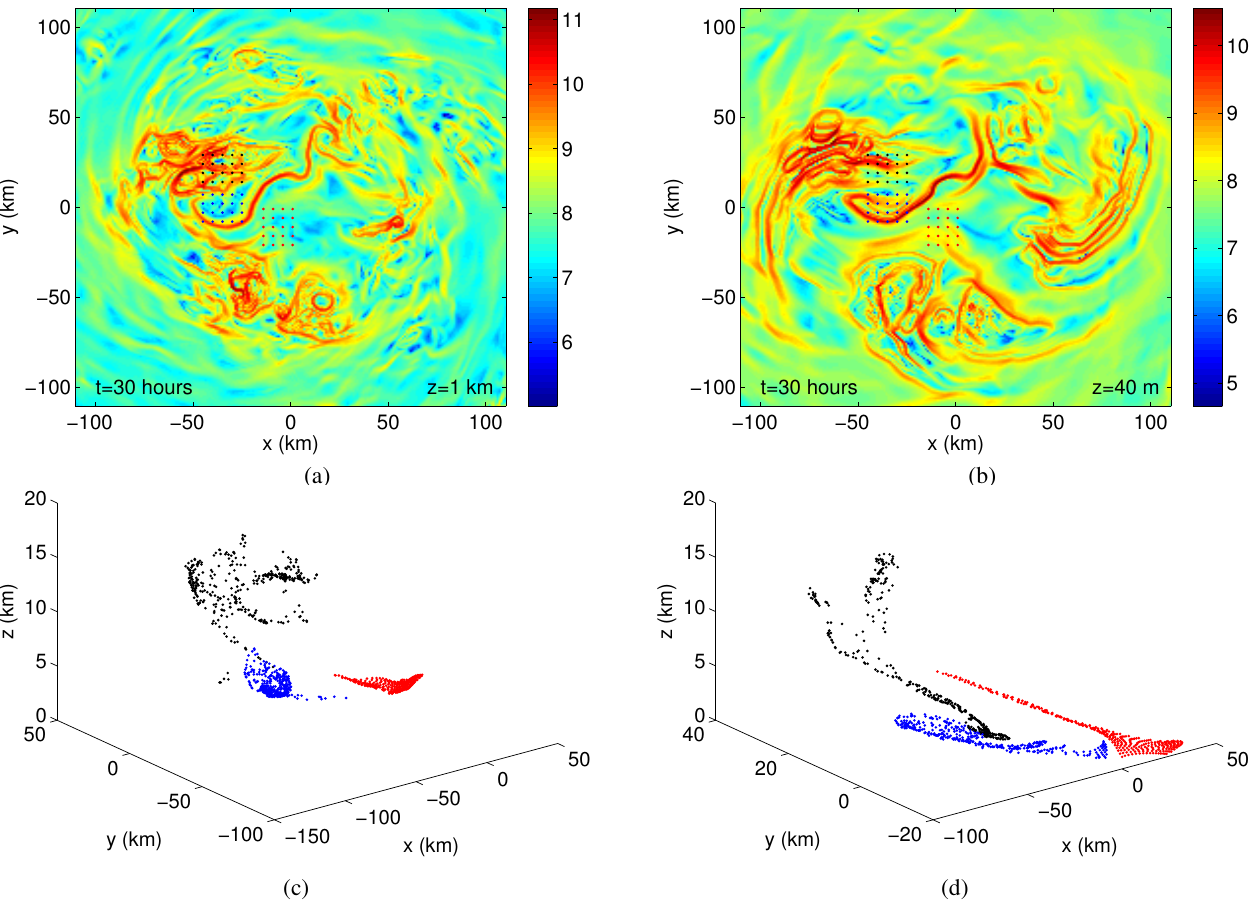
Fig. 5. LCSs from the planar FTLE field are shown at z = 1 km (a) and at z = 40 m (b) with initial particle locations shown as blue, red and black dots. The final locations of the particles after a 1 hour integration are shown in (c) and (d) respectively.